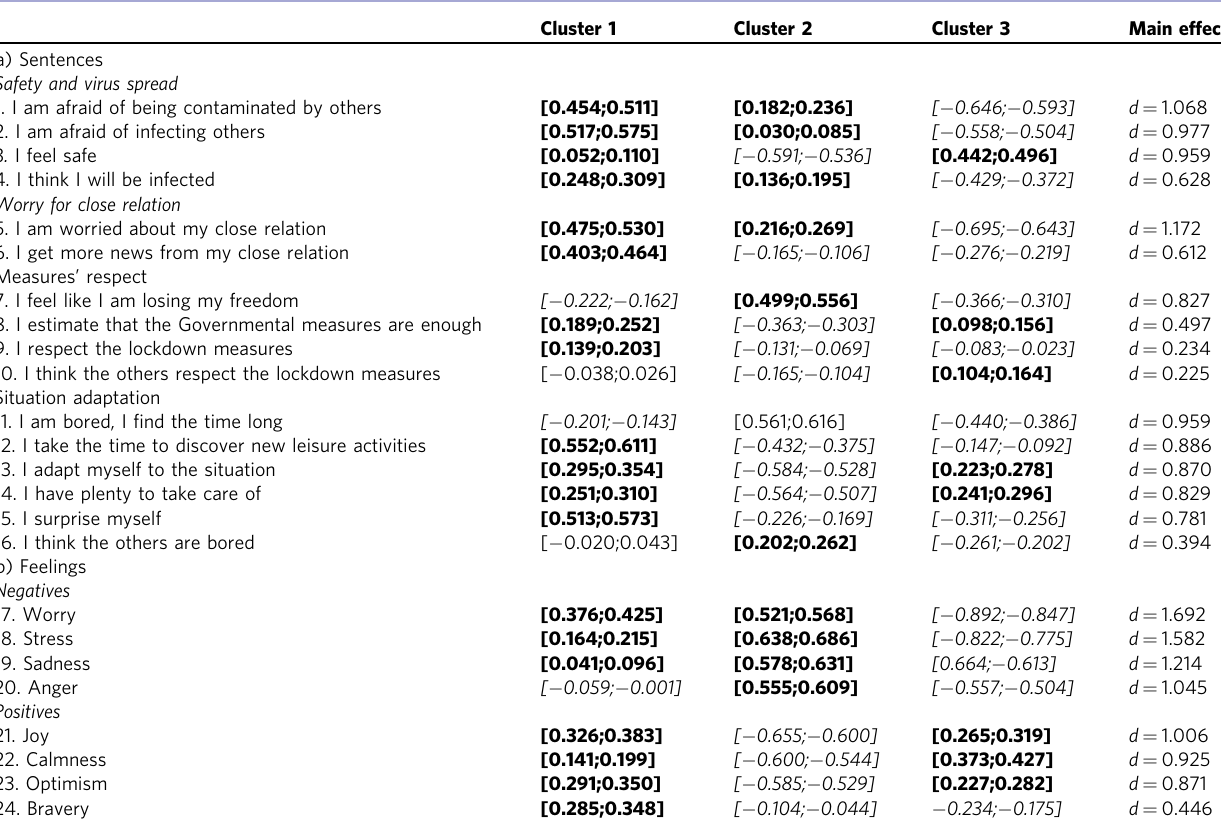
Table 2 Lockdown perception for the three generated